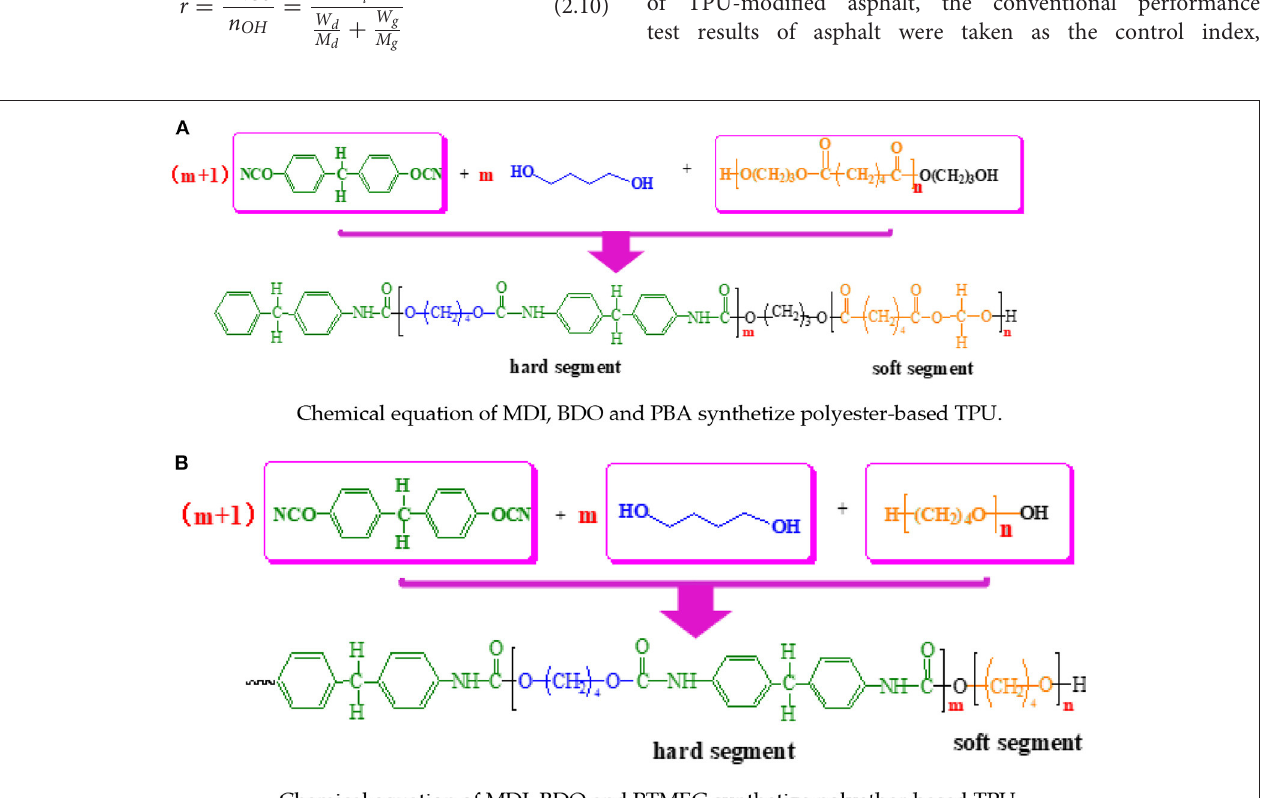
FIGURE 6 | Reaction mechanism of the TPU. (A) Chemical equation of MDI, BDO, and PBA synthetize polyester-based TPU. (B) Chemical equation of MDI, BDO, and PTMEG synthetized polyether-based TPU.